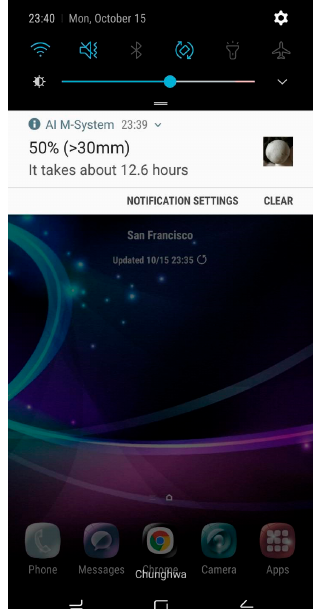
Figure 10. The broadcast message indicating the estimated harvest time.